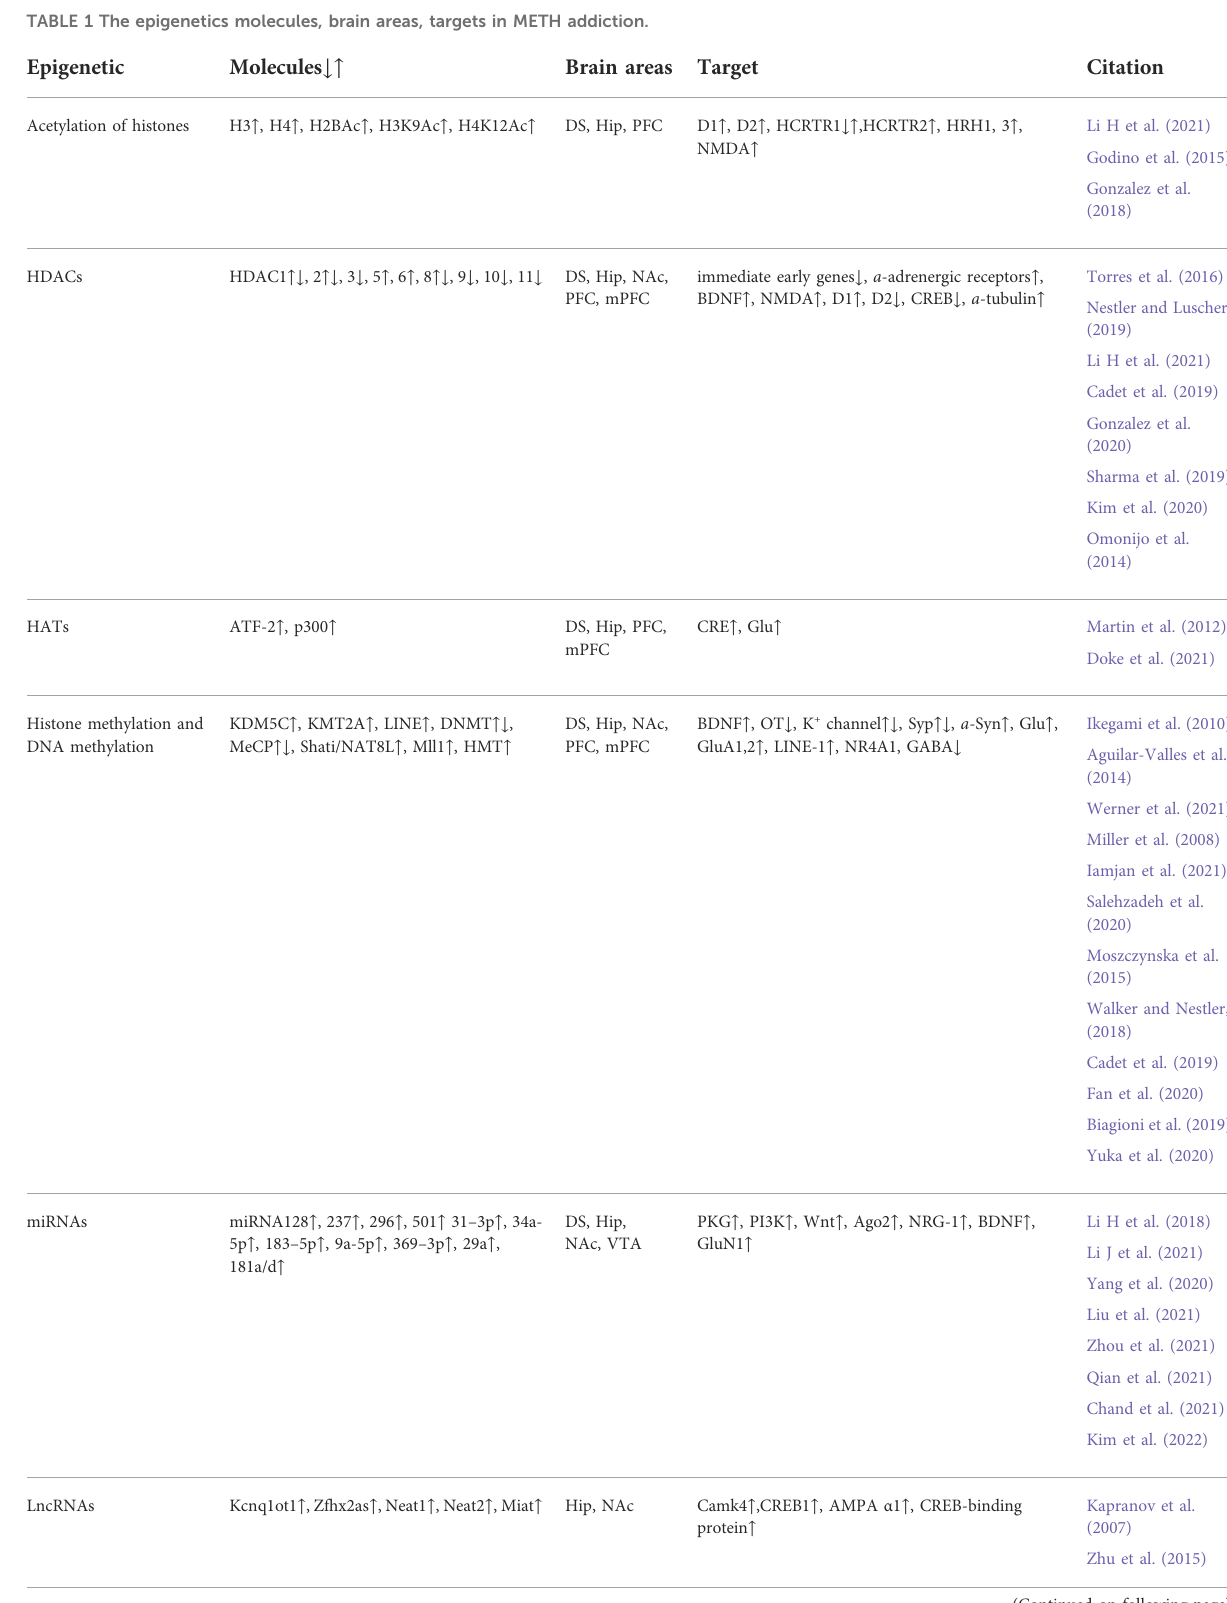
TABLE 1 The epigenetics molecules, brain areas, targets in METH